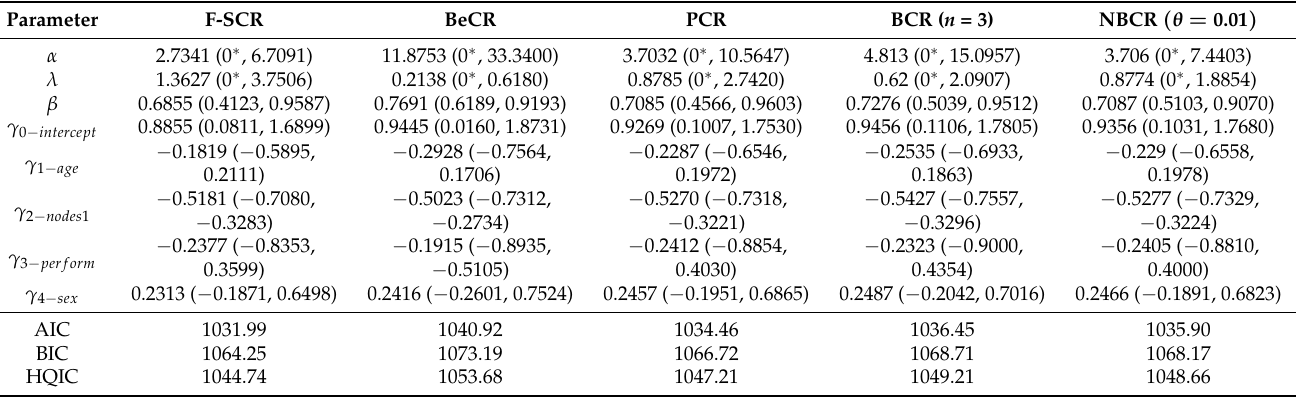
Table 4. ML estimators (95% confidence intervals) and information criteria for the melanoma cancer data set based on GeTNH distribution.